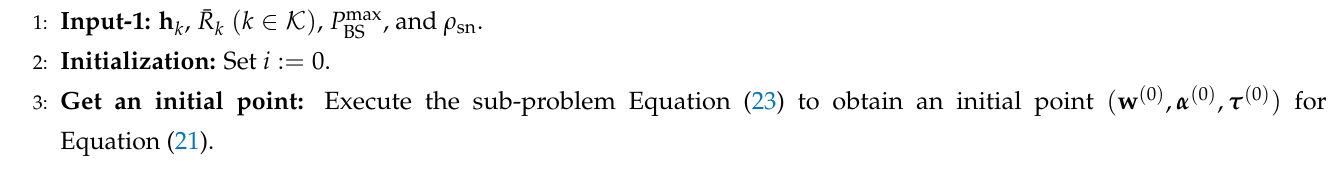
Algorithm 1 Proposed Algorithm for Solving Problem Equation (8) based on IA Method. Phase